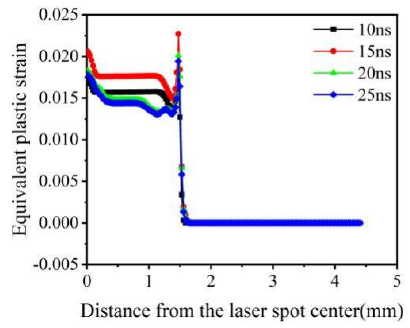
Figure 9. Equivalent plastic strain of 20CrMnTi at different pulse widths.